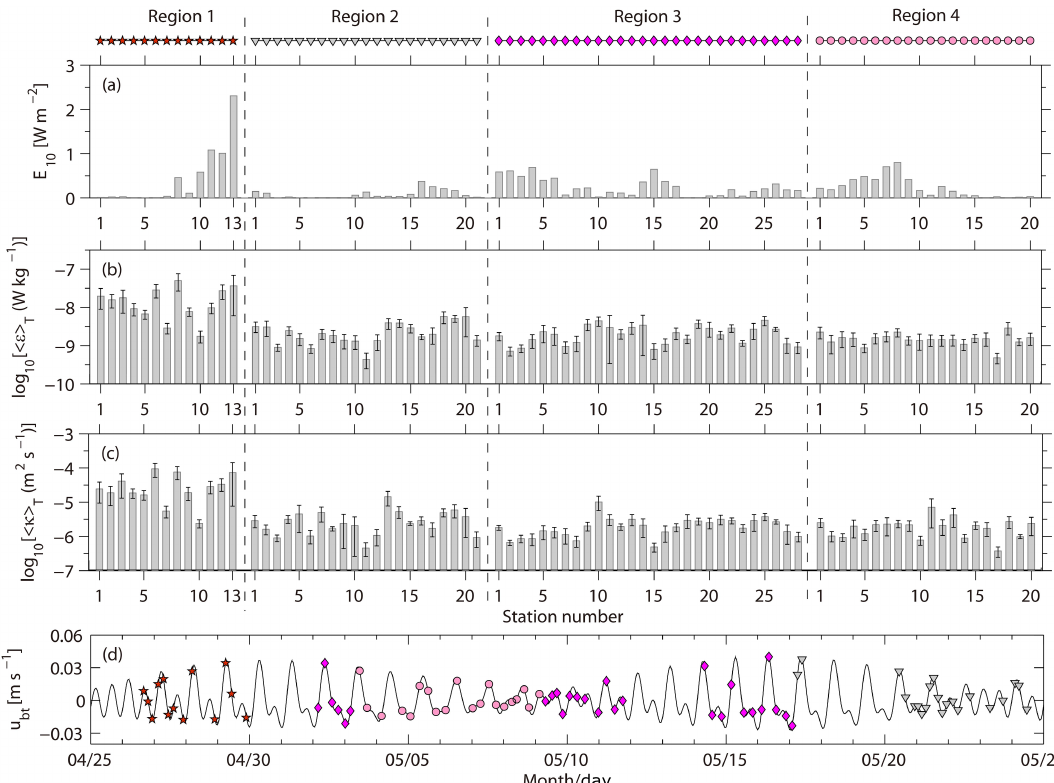
Figure 7. (a) Wind energy flux E 10 for each station during the TurboMAP measurement. (b) The average dissipation rate (cid:104) ε (cid:105) T and (c) average diapycnal diffusivity (cid:104) κ (cid:105) T in the thermocline. The vertical bars in (b) and (c) indicate the 95% bootstrapped confidence interval. The vertical dashed lines divide the stations into four regions with symbols (red stars, gray triangles, magenta diamonds, and pink dots) shown at the top of (a) . These symbols correspond to the station symbols in Fig. 1a. (d) Time series of the barotropic tidal velocity ( u bt ) predicted from TPXO 7.1 with the station symbols